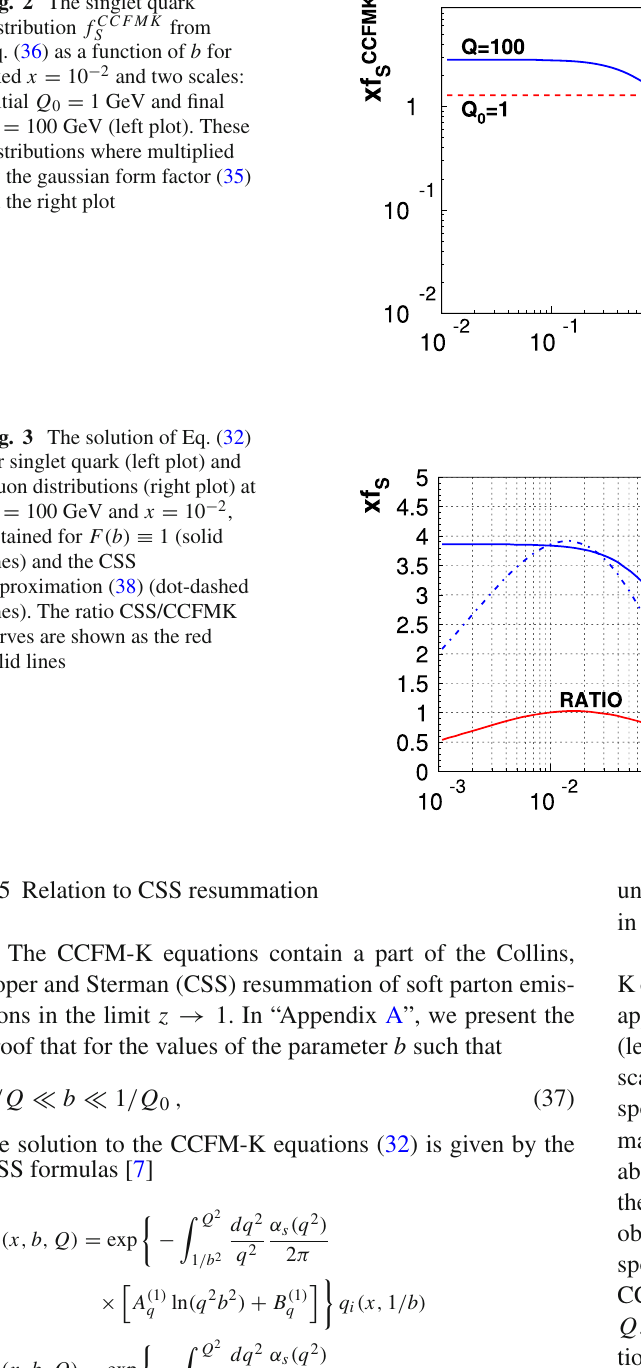
Fig. 2 The singlet quark distribution f CCFMK from S Eq. (36) as a function of b for fixed x = 10 − 2 and two scales: initial Q 0 = 1 GeV and final Q = 100 GeV (left plot). These distributions where multiplied by the gaussian form factor (35) on the right plot